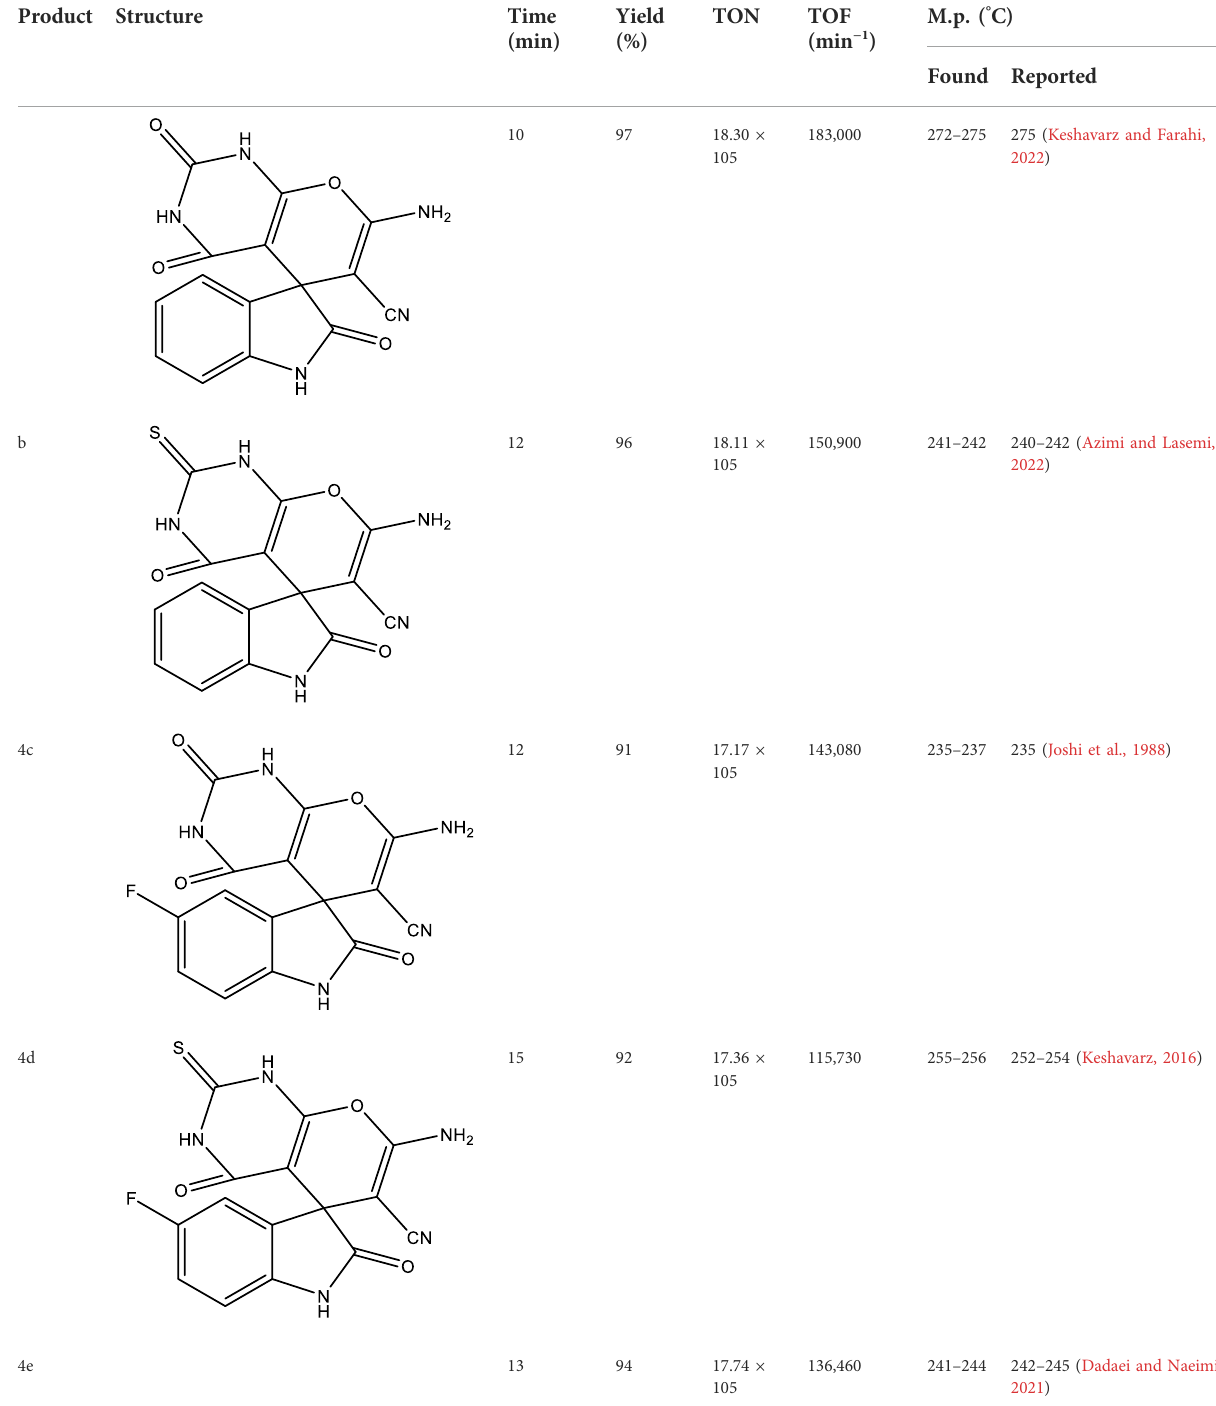
TABLE 3 Synthesized derivatives of spiro [indoline-pyranopyrimidines] derivatives (4a-l) by Fe 3 O 4 /Zn-metal organic framework magnetic nanostructures. Product